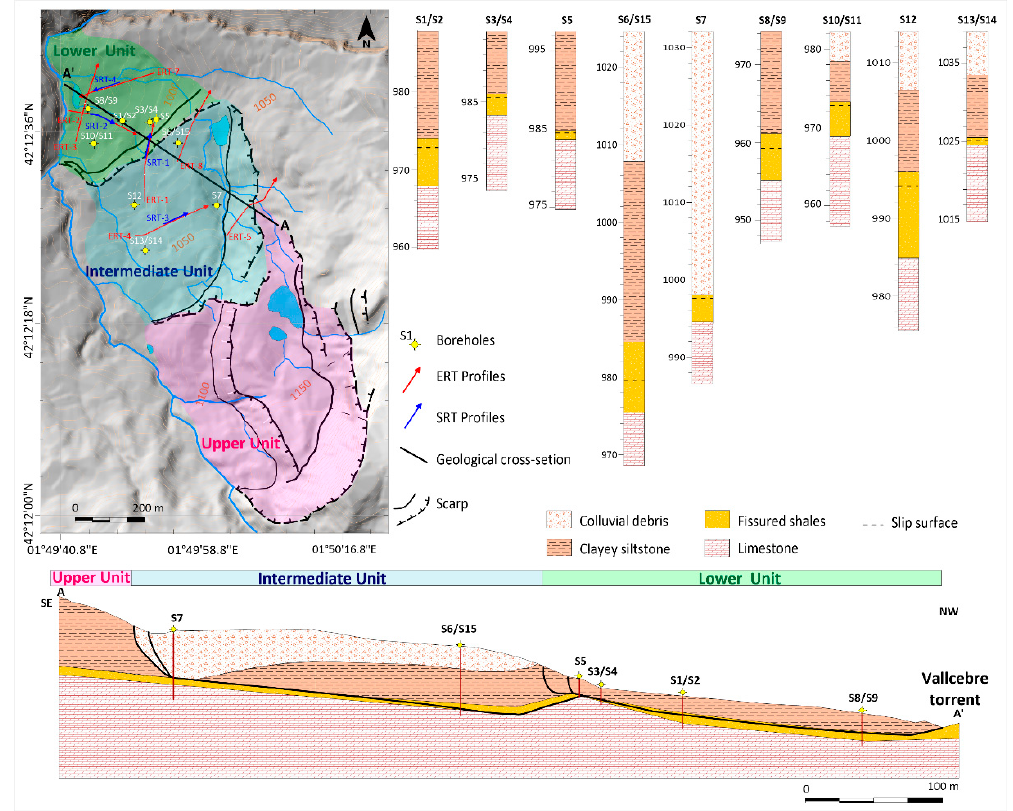
Figure 2. Location of the geophysical surveys and simplified lithological logs of and the geological cross-section A’—A boreholes (Vallcebre area). Modified from [21].